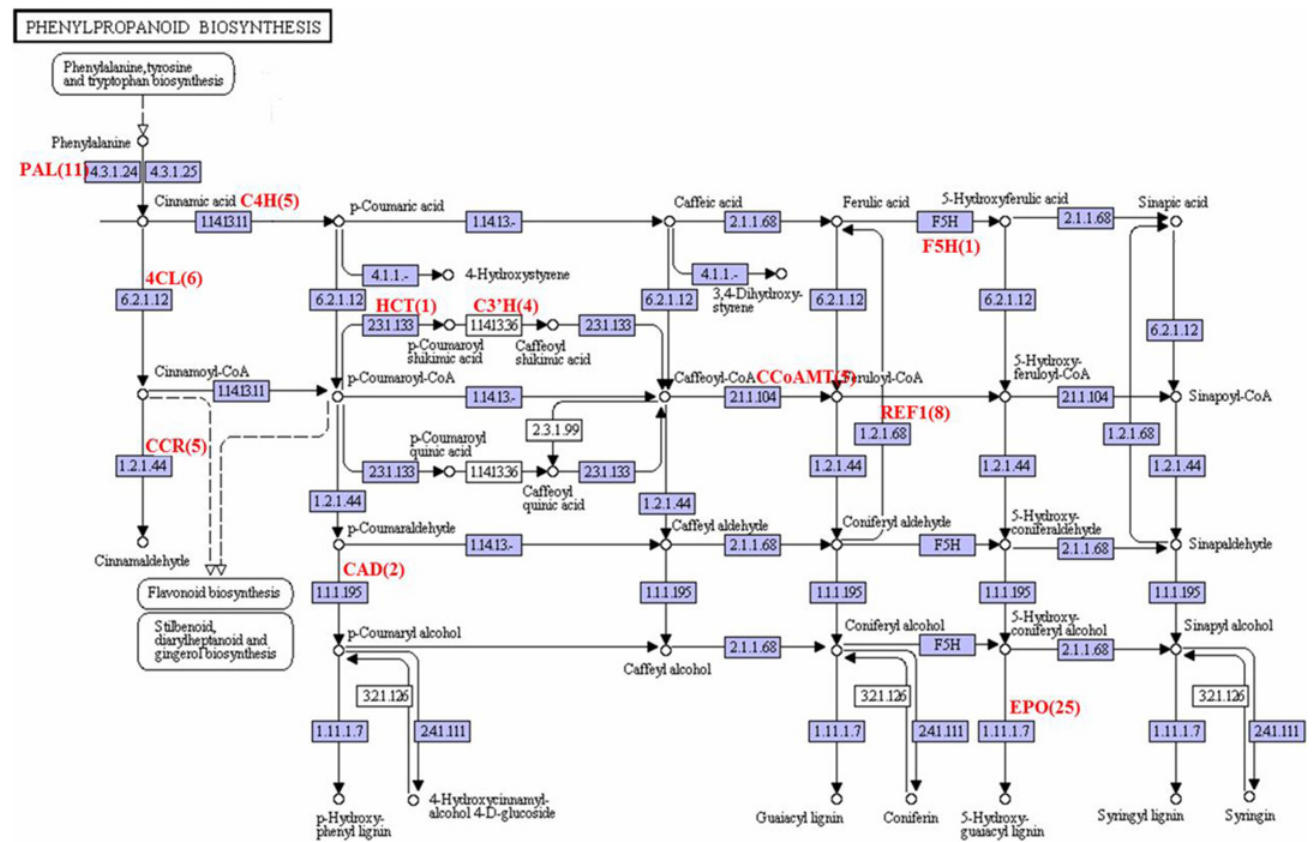
Fig 8. The Phenylpropanoid biosynthesis. The A. comosus var. bracteatus transcripts encoding enzymes (highlighted) involved in the pathway was identified by BLASTx (E-value of less than 10 – 5). Numbers in bracket are the total number of unigenes encode for the